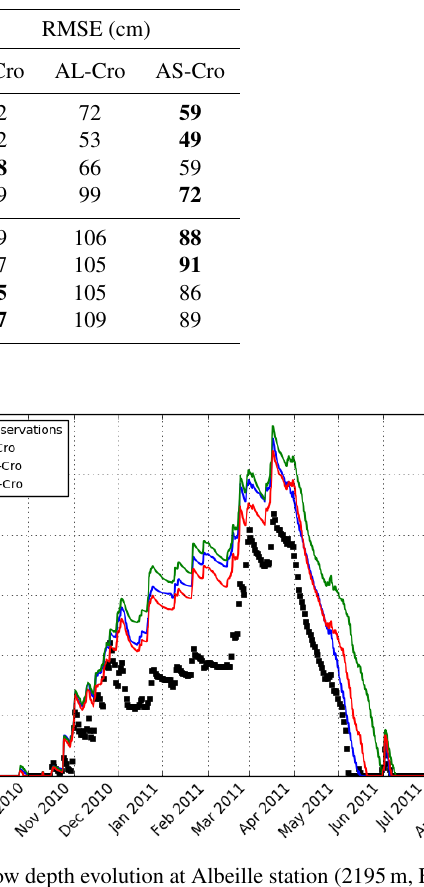
sents the SWE (snow water equivalent) simulated by A-Cro taken as a reference on 1 February 2013 during the accumu- lation period and on 1 May 2013 during the melting period, and the differences between AL-Cro, AS-Cro and this ref- erence at the same dates. The differences with AL-Cro are generally between − 50 and + 50 mm on 1 February 2013. AS-Cro exhibits lower SWE values at this date, due to its higher LW ↓ irradiance. However, on 1 May 2013, both sim- ulations exhibit higher SWE values than A-Cro almost every- where, with differences mostly higher than 200 mm, locally reaching 400 mm, due to lower SW ↓ irradiances.